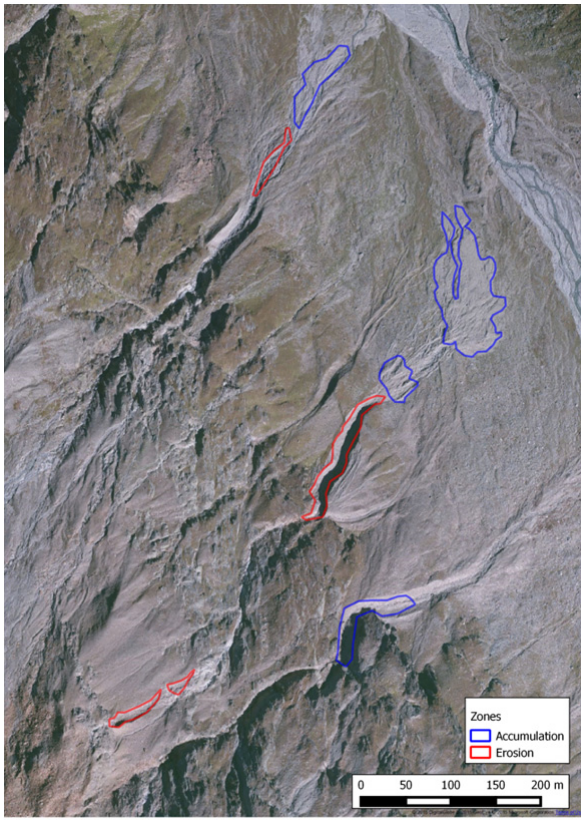
Figure 9. Erosion and accumulation areas in the proglacial zone of Hangerer Ferner